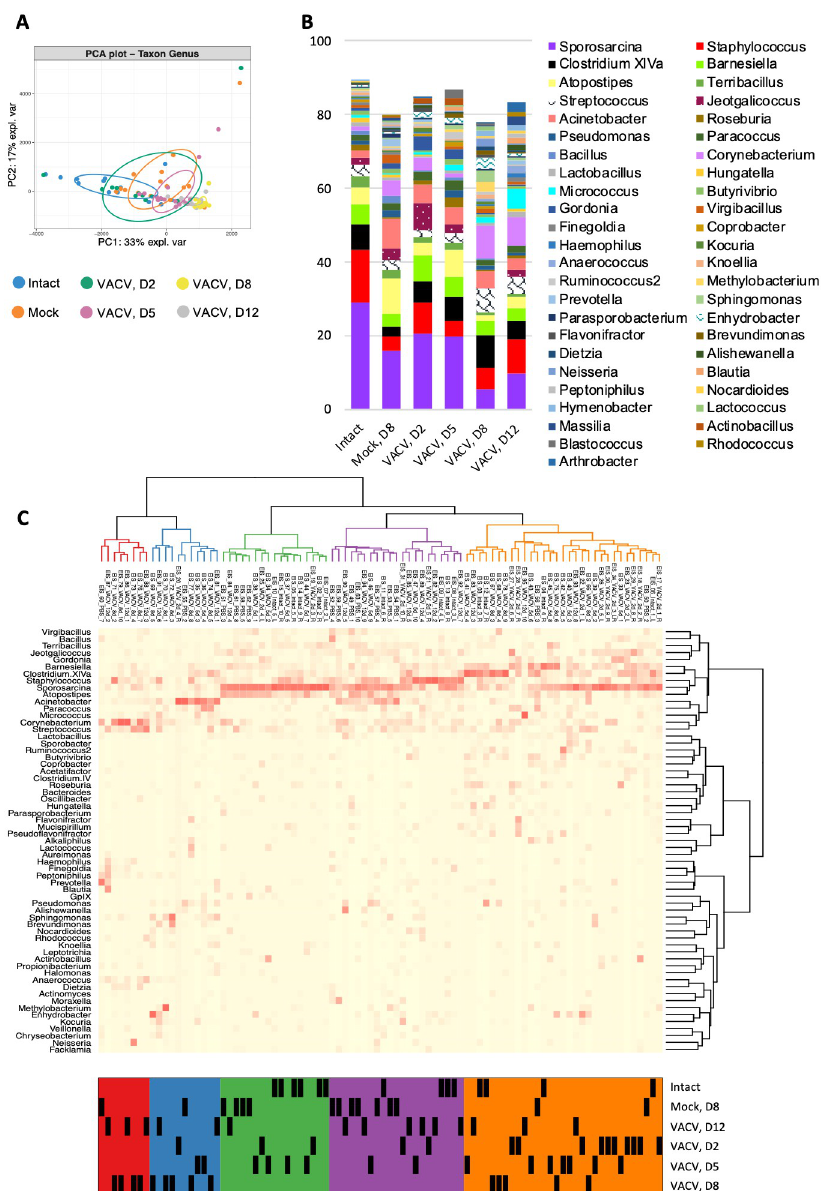
Fig 2. Skin microbiome change after i.d. infection with VACV. Ear tissues were collected from SPF mice before (intact) and at 2, 5, 8 and 12 d p.i. with 10 4 PFU of VACV and at d 8 post PBS injection (mock), n = 15 per group per time point. Next generation sequencing was performed for DNA samples extracted from tissue. (A) Principal Component Analysis (PCA) of microbiome of genus taxon. PCA was conducted including all taxon with a minimum abundance of 0.1%. Ellipses represent a 40% confidence interval around the cluster centroid. (B) Relative abundance of most prevalent taxa of bacterial genera. (C) Heatmap of bacterial genera with hierarchical clustering. Bacterial genera with a minimum abundance of 1% in at least five samples was used for creation of the heat map. Five clusters are colour-coded with red, blue, green, violet and orange. “D”–day post injection.